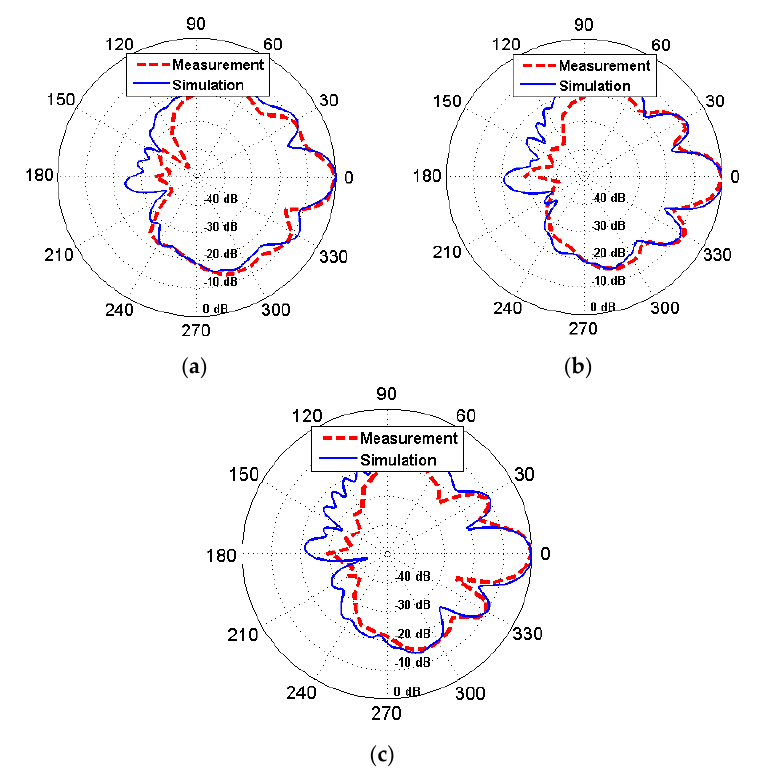
Figure 17. Far-field radiation pattern of H-plane SIW antenna array with three-way in-phase right-angled power divider at φ = 0 and θ between 0 and 360 degrees at ( a ) 22 GHz, ( b ) 22.5 GHz, and ( c ) 23 GHz.